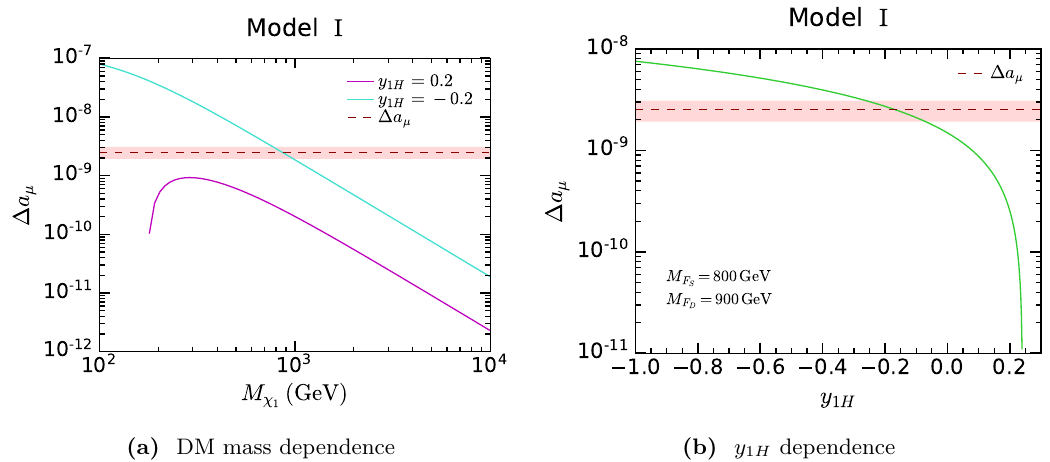
Figure 2. In the left panel we show ∆ a µ as a function of DM mass M χ parameter points y 1 H = 0 . 2 and y 1 H = − 0 . 2 , with M F right panel, we show ∆ a µ as a function of y 1 H , fixing M F M ˜ = 1000 GeV . The rest of the parameters in the both panels are set to be y 1 = y 2 = λ L = λ 0 L 0 . 5 and y 2 H = 0 . 3 . The horizontal dashed line indicates the measured value of ∆ a µ , with its error indicated by the red